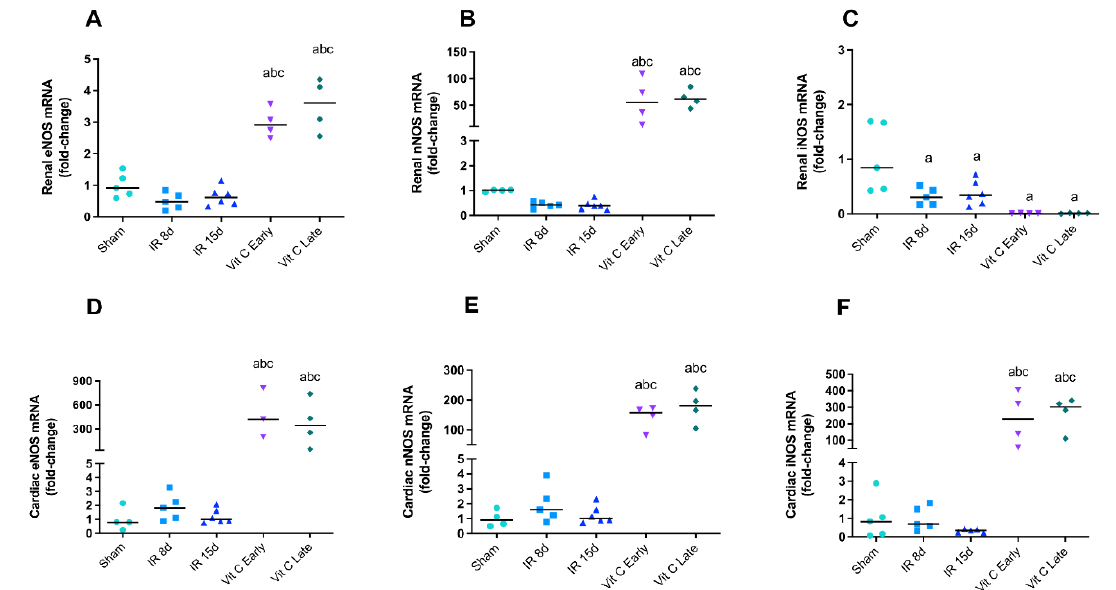
Cells 2021 , 10 , x FOR PEER REVIEW Figure 4. Vitamin C modulates nitric oxide synthase isoforms after IR. eNOS mRNA levels ( A ), nNOS mRNA levels ( B ), and iNOS mRNA levels ( C ) in the left kidney. eNOS mRNA levels ( D ), nNOS mRNA levels ( E ), and iNOS mRNA levels ( F ) in heart. Data are expressed as the mean ± standard error of mean (SEM) and one-way ANOVA followed by the Tukey’s post hoc test were performed. a vs. sham, p < 0.05. b vs. IR8d, p < 0.05. c vs. IR15d, p < 0.05.